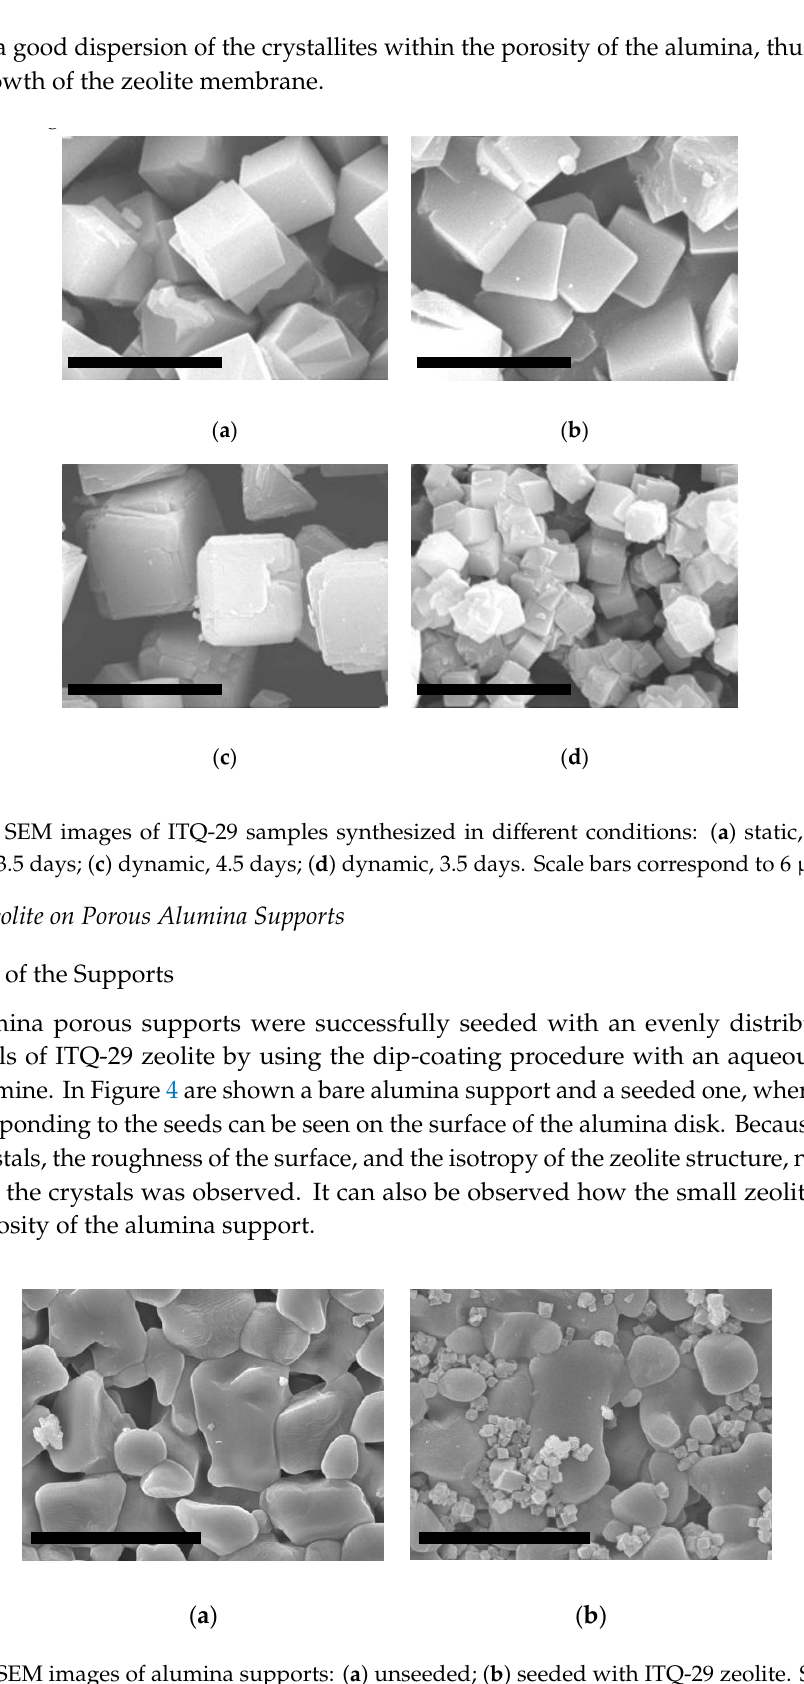
Figure 4. SEM images of alumina supports: ( a ) unseeded; ( b ) seeded with ITQ-29 zeolite. Scale bars correspond to 10 µm.